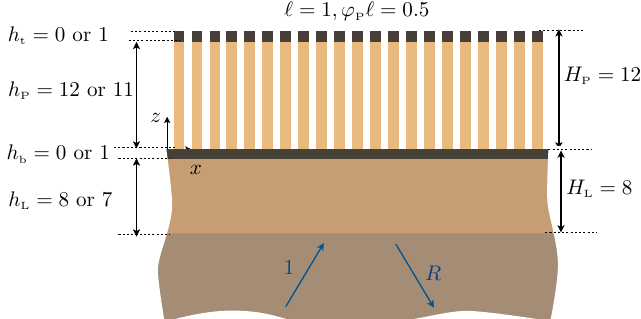
= h + h = 12 of the array and the total P P b = 1, ϕ = ϕ = 0.5. When the b t P